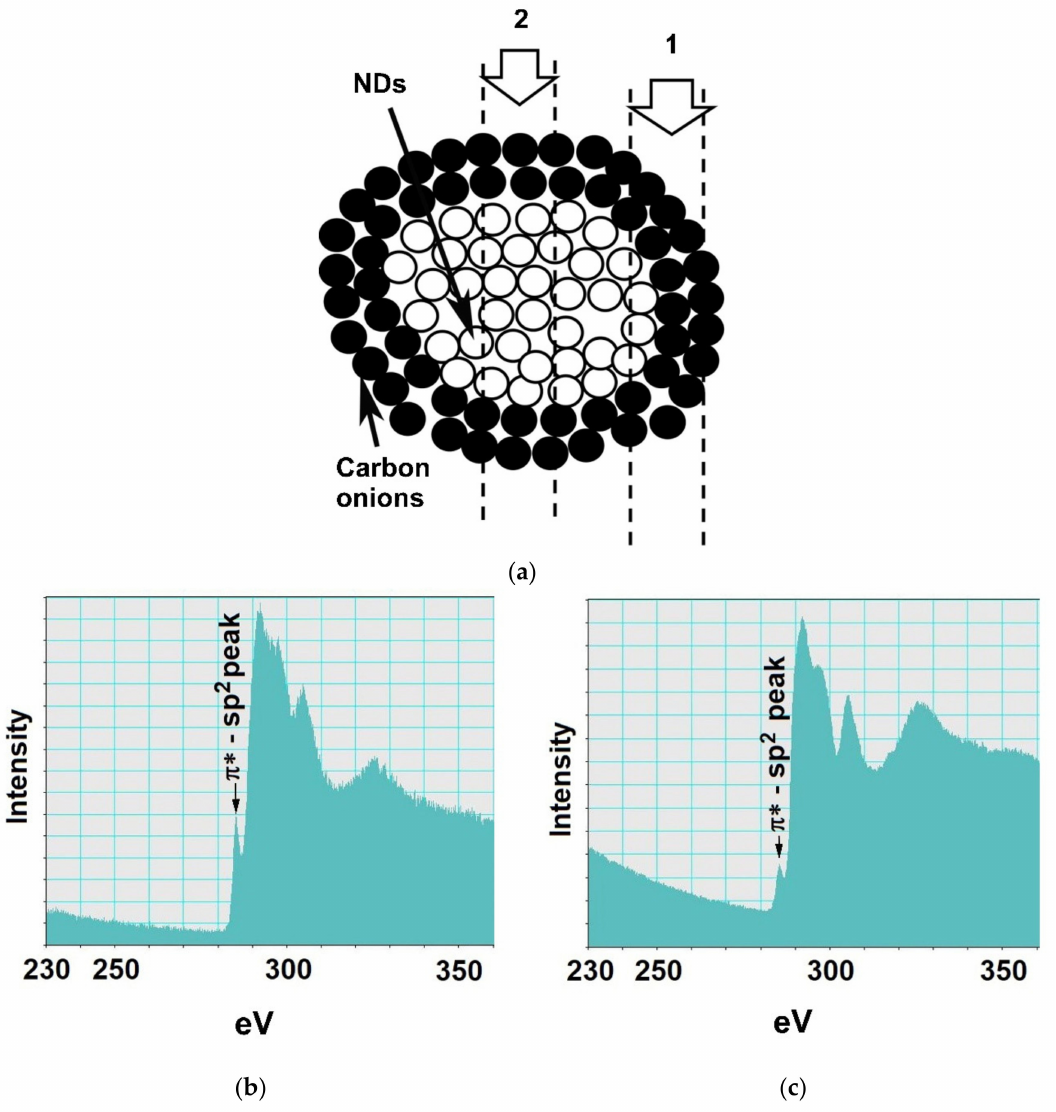
Figure 7. EEL spectra for the surface and central layers of the ND agglomerate: ( a ) method of data collection; ( b ) EEL spectrum from zone 1 (particles from surface layers); and ( c ) EEL spectrum from zone 2 (mainly particles from central